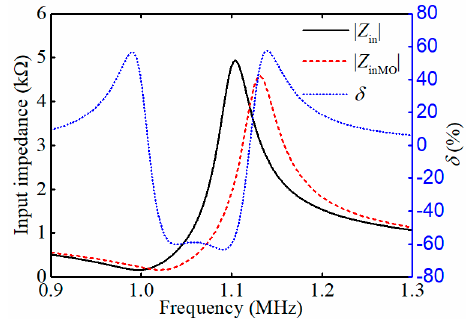
Figure 10. The input impedance of the resonant circuit and δ change with the operating frequency f .